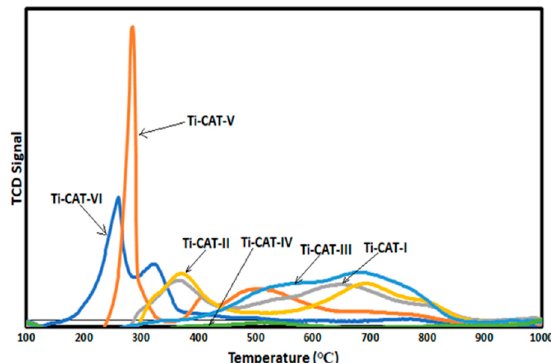
Figure 3. TPR profiles of the promoted and un-promoted catalysts.